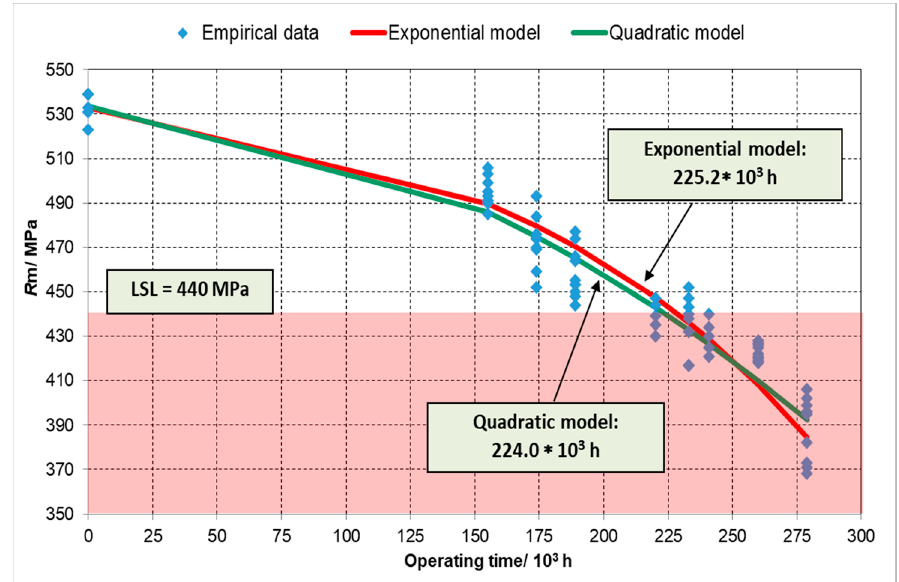
Figure 2. The course of the R m change depending on the operating time for the elbow bend made of fresh steam (FS) group steel at the longitudinal location of the samples tested.